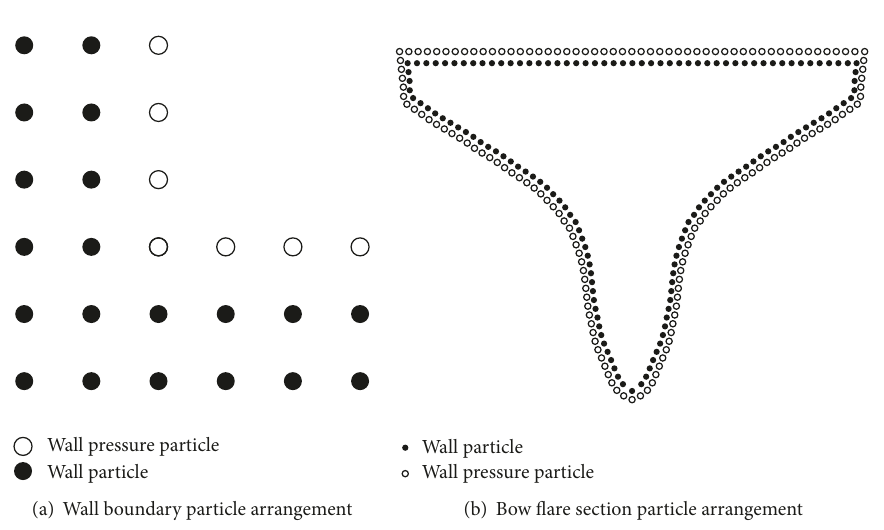
Figure 2: Neighbor search method.